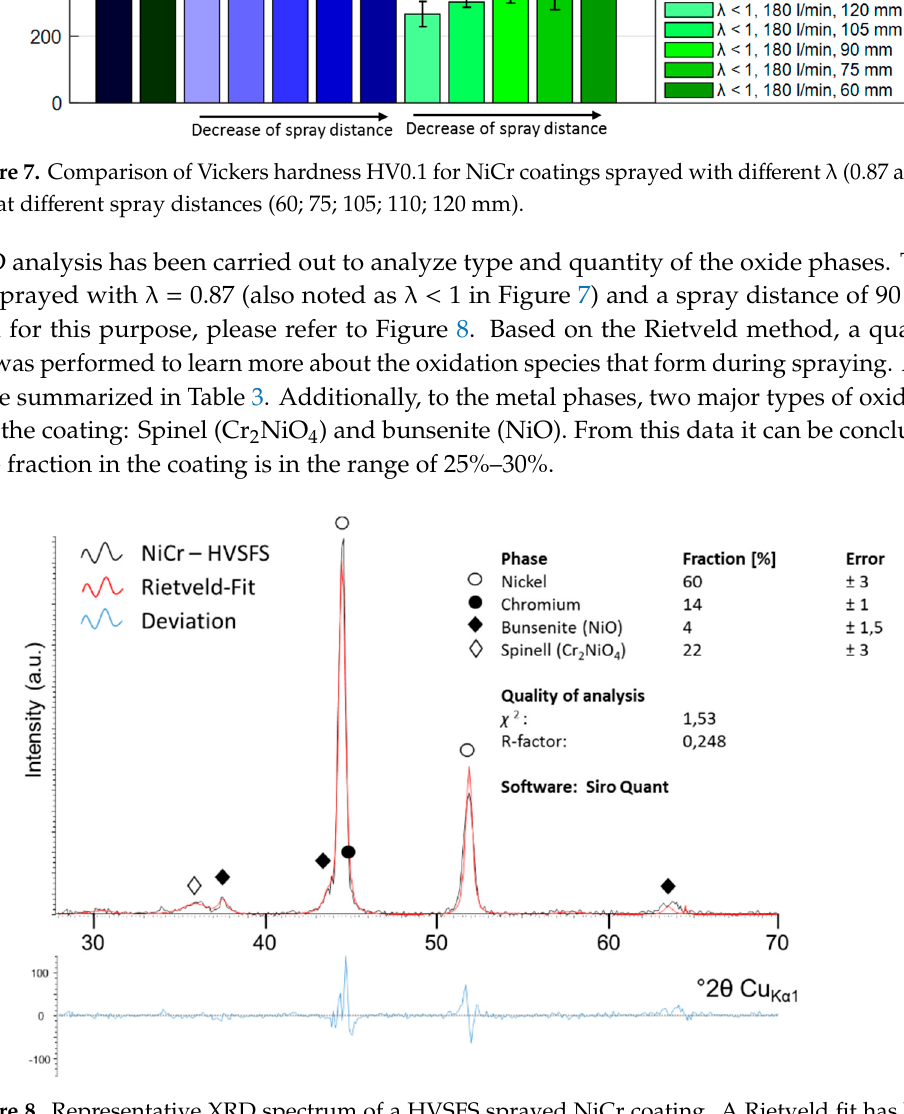
Figure 8. Representative XRD spectrum of a HVSFS sprayed NiCr coating. A Rietveld fit has been applied to the spectrum. Spray parameters ( λ = 0.87; total gas flow: 180 L/min; spray distance: 90 mm).